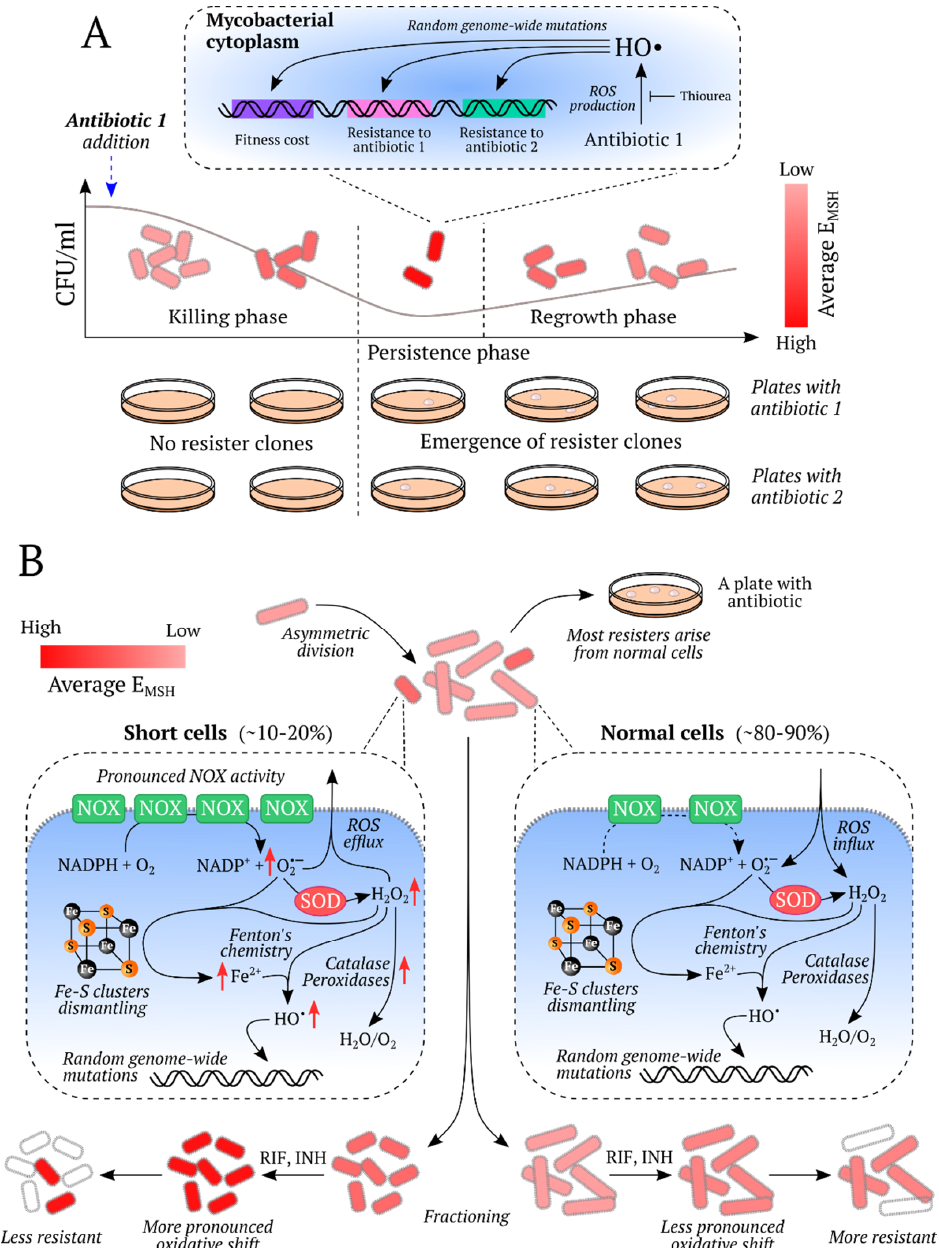
Figure 11. Redox processes that lead to the emergence of antibiotic resisters in mycobacteria. ( A ) Prolonged exposure of mycobacterial cells to antibiotic is characterized by three phases (“killing”, “persistence” and “regrowth”). The second phase is accompanied by elevated reactive oxygen species (ROS) production which stimulates genome-wide mutagenesis and consequent emergence of resisters. However, it should be mentioned that since DNA modification by ROS is random, the surviving cells experience a fitness cost due to undesired mutations [249,253]. ( B ) In mycobacterial populations, two fractions of cells can be found in regard to the cellular length, which result from asymmetric divisions. Short cells are characterized by elevated ROS production, which on the one hand lowers their resistance to environmental stresses, but on the other allows them to act as ROS-producing “factories” that stimulate the emergence of antibiotic resisters among normal cells [247,248].